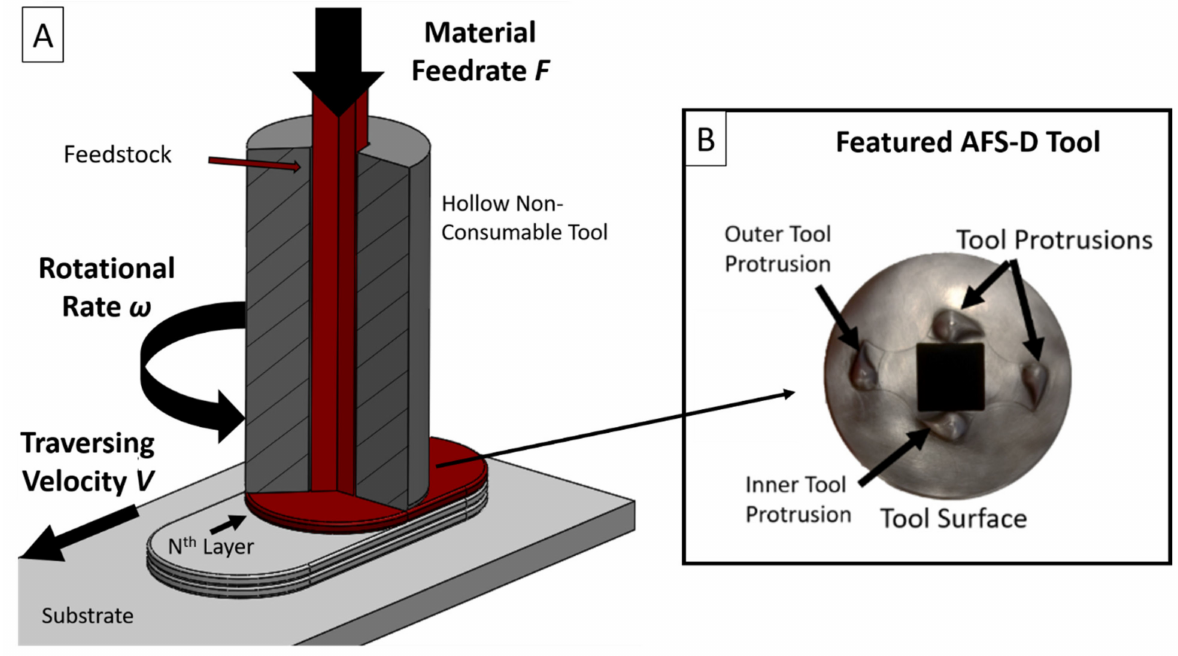
Figure 1. ( A ). Schematic of the AFS-D process denoting specific features and process control variables. ( B ) Schematic of the features located on the interaction face of the steel AFS-D